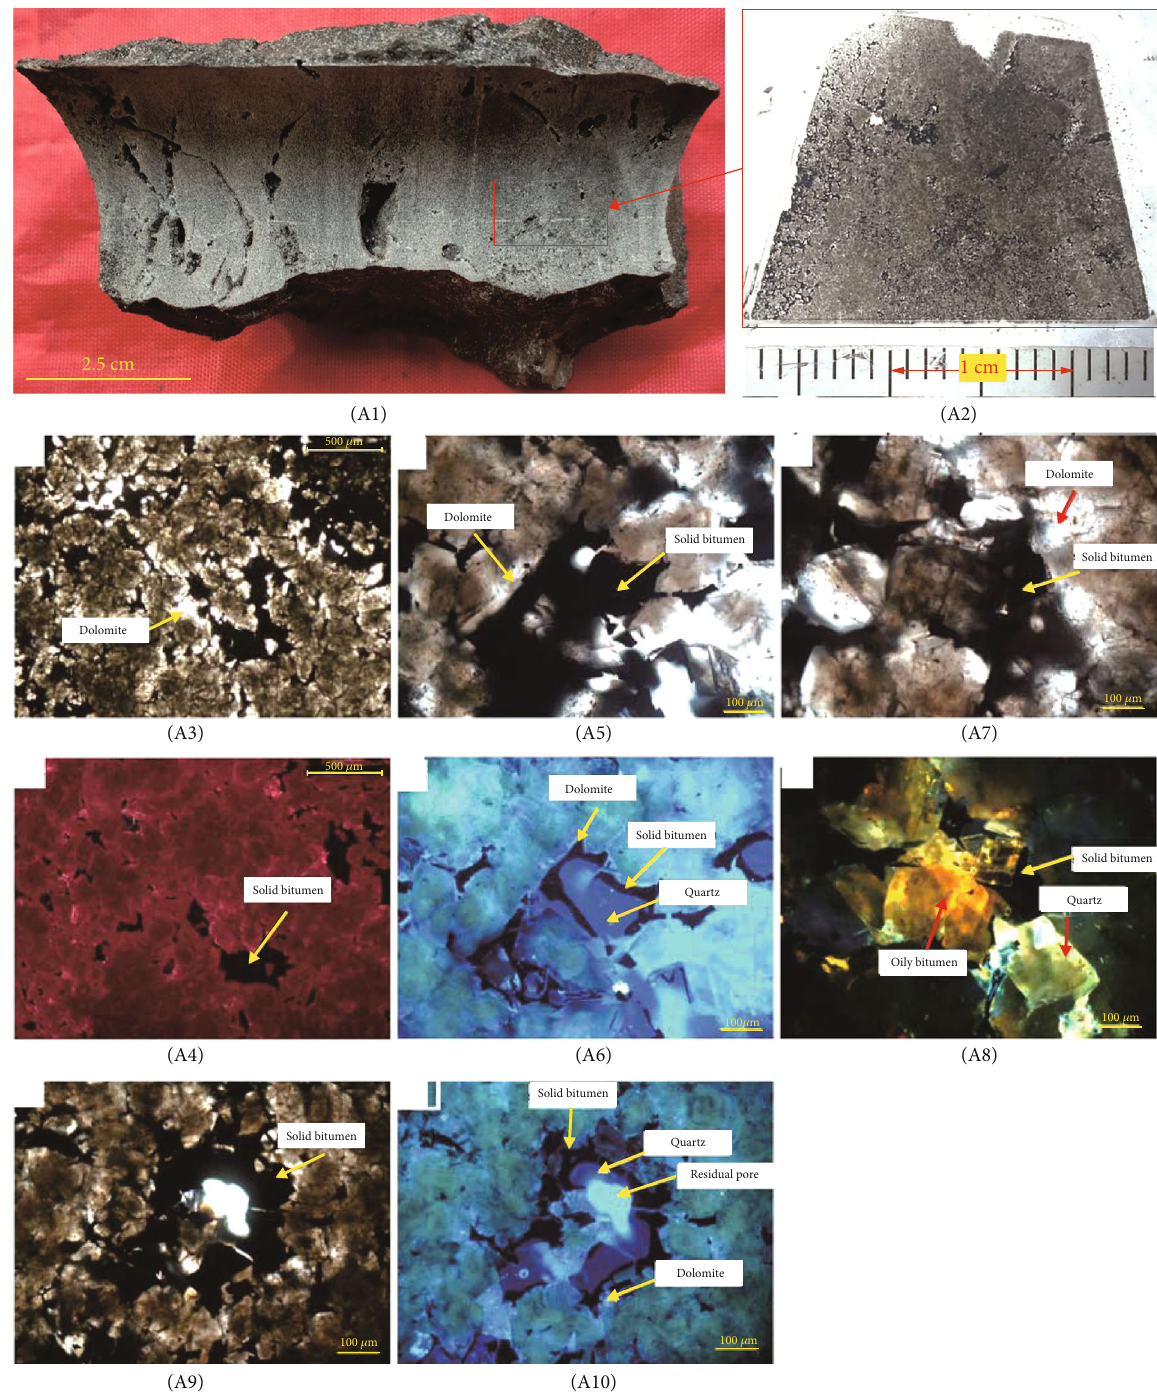
Figure 2: The Longwangmiao Formation Well MX26 4924.28m. Photos of cores and thin sections from the associated petrological observations. (A1) Algal silt, crystal dolomite with dissolution pores and cavities visible at core scale. (A2) Thin-section scan showing the intercrystalline pores and dissolution cavities of dolomite fi lled with asphalt. (A3) (-) Powder crystal dolomite with bright edges and a foggy center. (A4) (CL) Crystal showing a ring-shaped structure with intercrystalline pores fi lled with solid pitch; the foggy center of the crystals glows dark red and the bright edges glow scarlet under cathode light. (A5) (-) and (A6) (UV) Fill suite of intercrystalline pores of fi ne powder crystal dolomite: Dolomite, non fl uorescent solid pitch. (A7) (-) and (A8) (UV) Pore fi ll types identi fi ed in intercrystalline pores in fi ne powder crystal dolomite with crystals showing bright edges and foggy centers included the following: dolomite → non fl uorescent solid asphalt → yellow fl uorescent oily asphalt. (A9) (-) and (A10) (UV) Pore fi ll types identi fi ed in intercrystalline pores in powder crystal dolomite dissolution pores included the following: dolomite → solid pitch → quartz → residual pores. (-): Plane- polarized light; UV: ultraviolet light; CL: